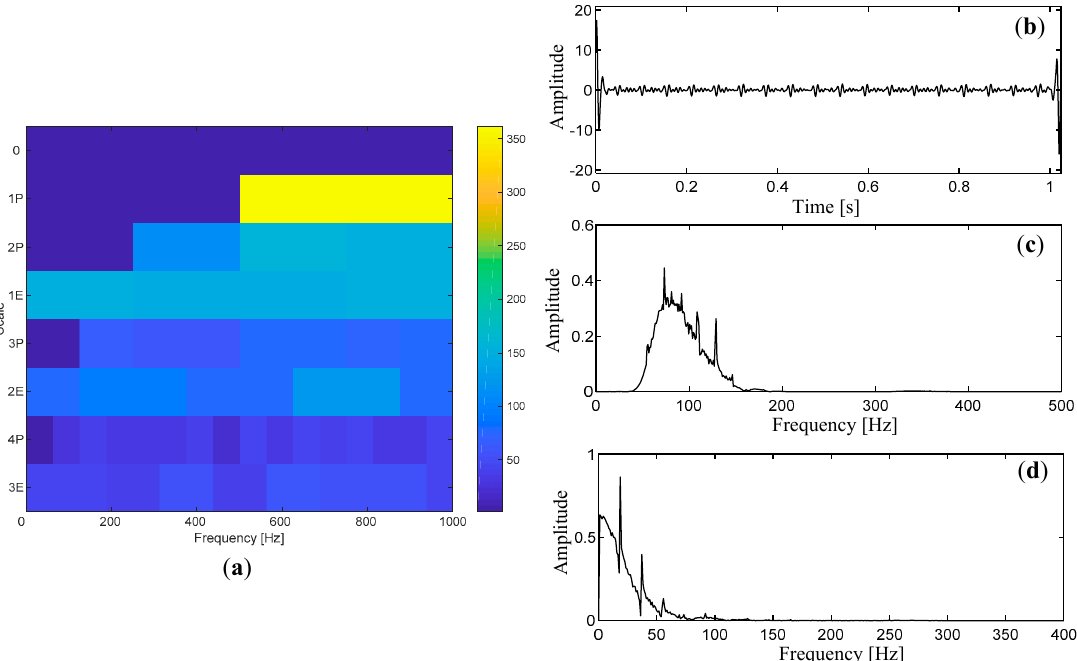
Figure 24. Analysis results of the displacement signal by wavelet decomposition: ( a ) distribution of kurtosis of each wavelet packet; ( b ) time domain waveform of wp 3,2 ( n ) ; ( c ) Fourier spectrum of wp 3,2 ( n ) ; and ( d ) Hilbert envelope spectrum of wp 3,2 ( n )